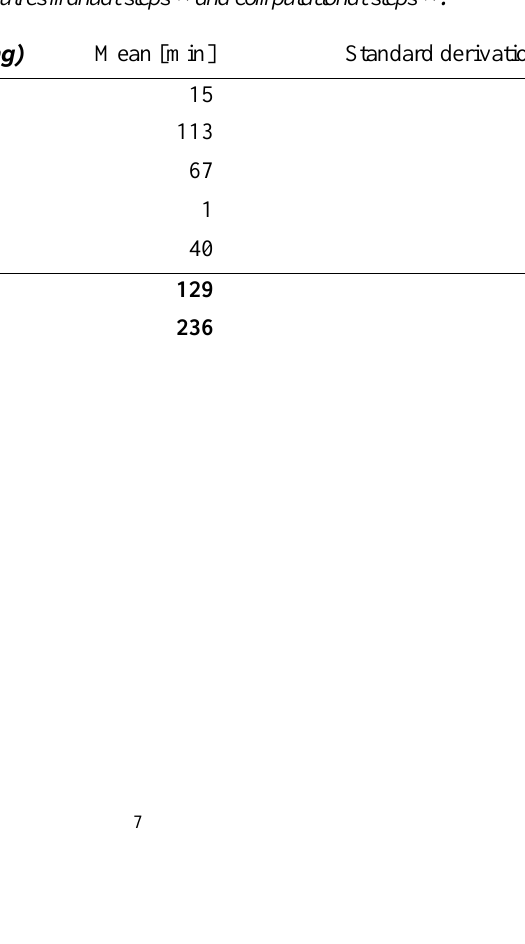
Table 3: cGOM - Overview of mapping sub-times (mean and standard derivation in minutes) of the computational mapping by the algorithm. The mapping aided by the algorithm requires manual steps (#) and computational steps (*)